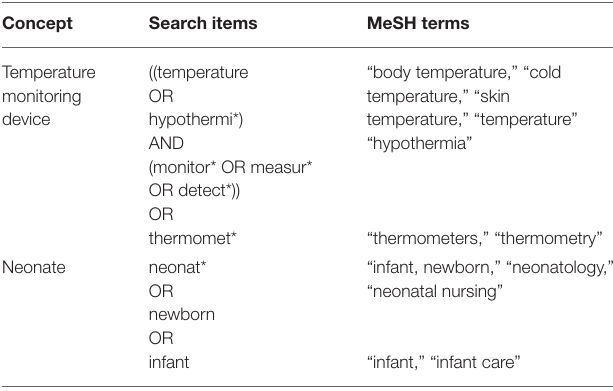
TABLE 1 | Search strategy—keywords and Medline medical subject heading (MeSH) terms used.